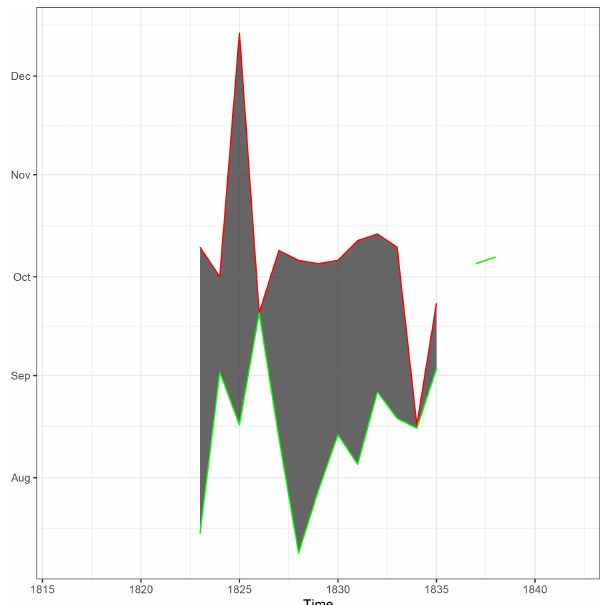
Figure 7. Reports of ague and fever in the Shirley Plantation doc- ument during the period 1823–1842. Data for 1839–841 have not been generated yet. There are two decades of data, minus the miss- ing years. Onset of symptoms indicates that the mean daily temper- atures had been above 18 ◦ C (64 . 4 ◦ F) long enough for the sporo- logical cycle of Plasmodium to complete in the host Anopheles mosquito. The green line indicates when the first case was reported. The red line indicates when the last report